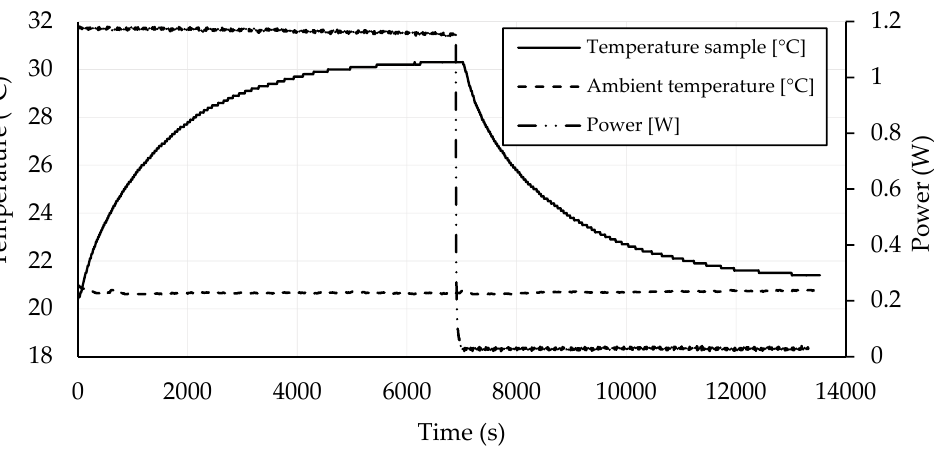
Figure 8. Self-heating experiment—CB 1.5, 100 V.